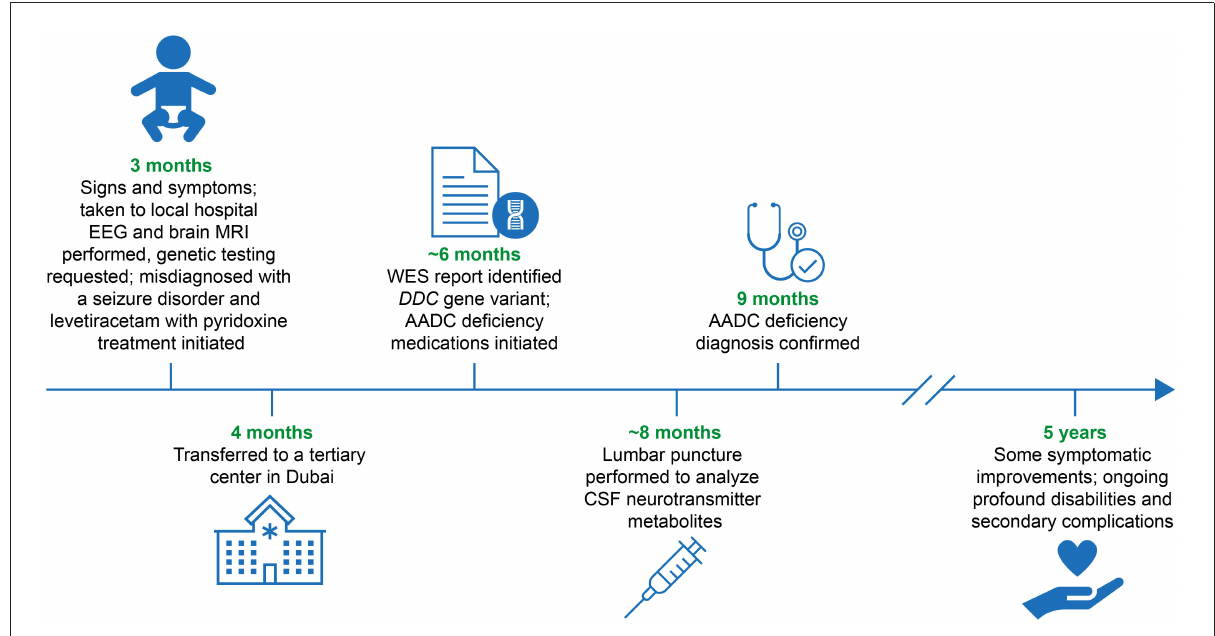
FIGURE1 Diagnostic and patient management timeline. AADC, aromatic L-amino acid decarboxylase; CSF, cerebrospinal fluid; DDC , L-DOPA decarboxylase; EEG, electroencephalogram; MRI, magnetic resonance imaging; WES, whole exome